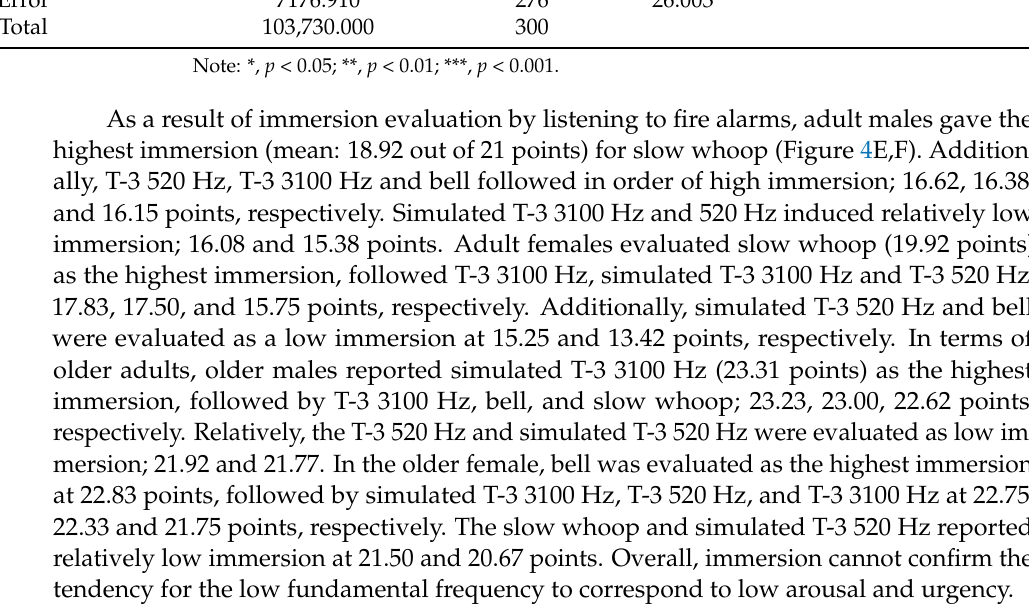
Figure 4. Results of psychoacoustic recognition induced by six different types of fire alarm sounds including age factor (left panels for young and right panels for old) and gender factors (light gray for male and dark gray for female): arousal ( A , B ), urgency ( C , D ), and immersion ( E , F ). In the older adults, males evaluated the highest arousal for simulated T-3 3100 Hz at 18.69 of 21 points. Additionally, bell, T-3 3100 Hz and slow whoop followed with 17.69, 17.69 and 17.62 points, respectively. Similar to the young adult males, the T-3 520 Hz and simulated T-3 520 Hz, which had low fundamental frequency, evaluated relatively low arousal; 16.85 and 15.46 points. For older adult females, T-3 3100 Hz reported the highest arousal at 18.83 points, followed by bell, slow whoop and simulated T-3 3100 Hz; 18.42, 18.42 and 18.25 points, respectively. The older females also reported relatively low arousal for simulated T-3 520 Hz and T-3 520 Hz, 16.08 and 15.50 points, respectively. As a result of three-way analysis variance, arousal had significant main effects de-